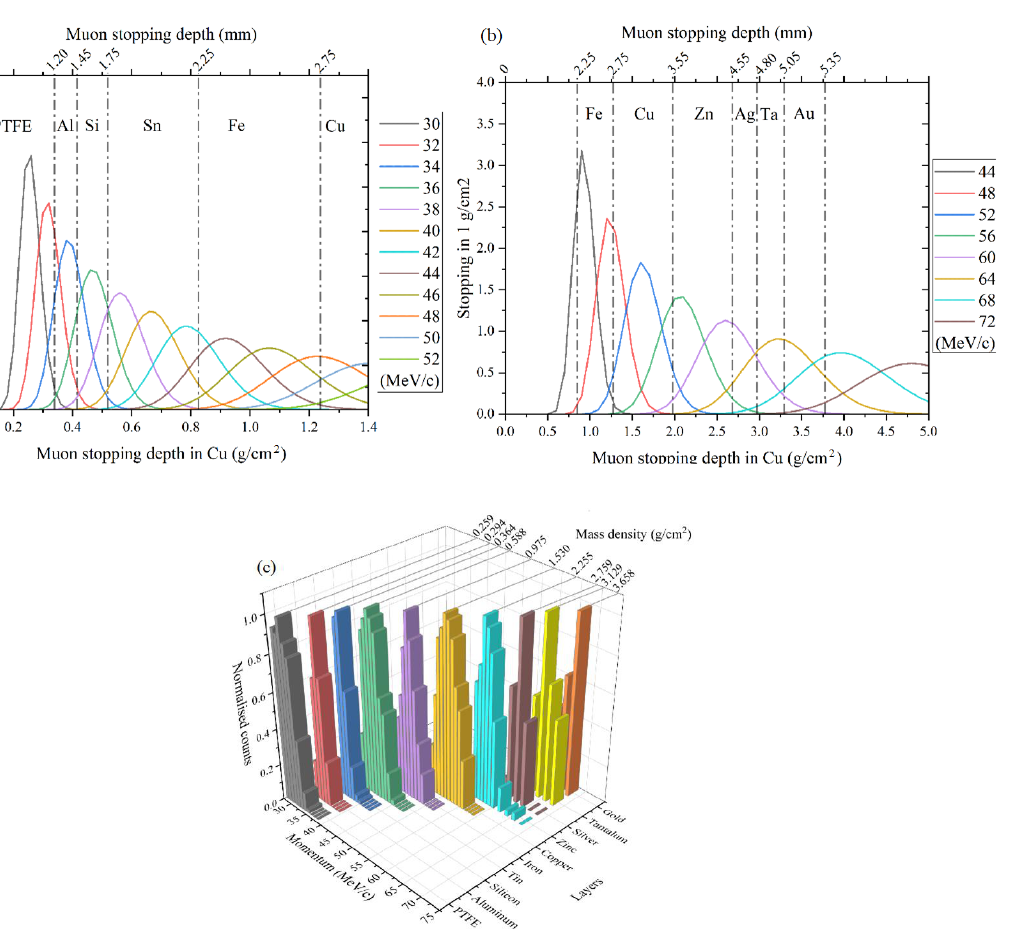
Figure 4. A schematic of the RIKEN-RAL beamline based at ISIS. Elemental analysis is currently performed at Port 4. The figure was taken and adapted, with permission from Ref. [7] © 2016 Elsevier Ltd.